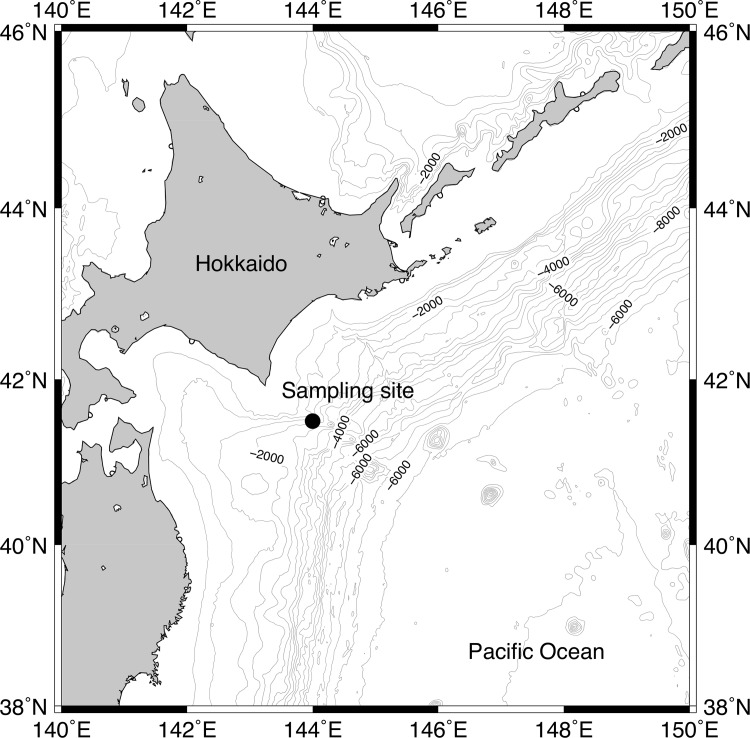
Location of the sampling station (41° 30’ N, 144° 00’ W) for the incubation experiment.